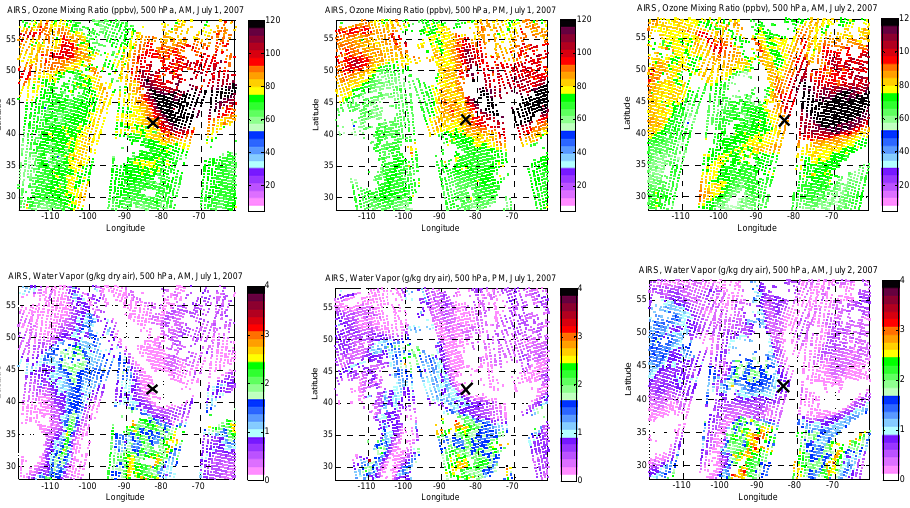
Figure 8: AIRS observations at 500 hPa (~5.5 km a.s.l.) on 1–2 July 2007. Upper plots: ozone Fig. 8. AIRS observations at 500hPa ( ∼ 5.5km a.s.l.) on 1–2 July 2007. Upper plots: ozone mixing ratio (ppbv); lower plots: water vapour mixing ratio (ppbv); lower plots: water vapour mixing ratio (g/kg dry air). The black cross shows mixing ratio (g/kg dry air). The black cross shows the location of Harrow. the location of Harrow.